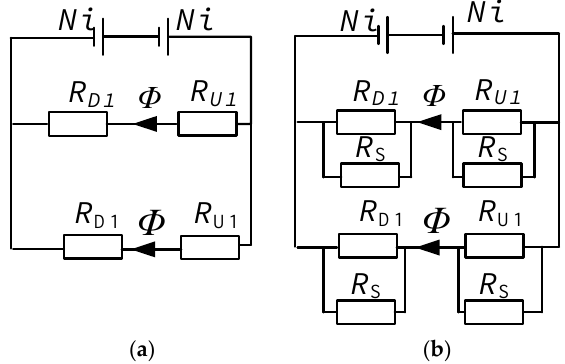
Figure 7. ( a ) Common equivalent magnetic circuit. ( b ) Equivalent magnetic circuit considering the edge effect.